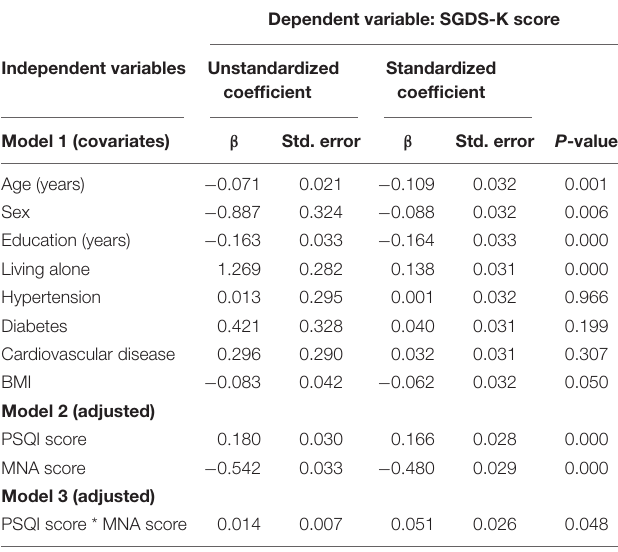
TABLE 2 | Multiple linear regression analysis for associations of depression with sleep and nutrition.